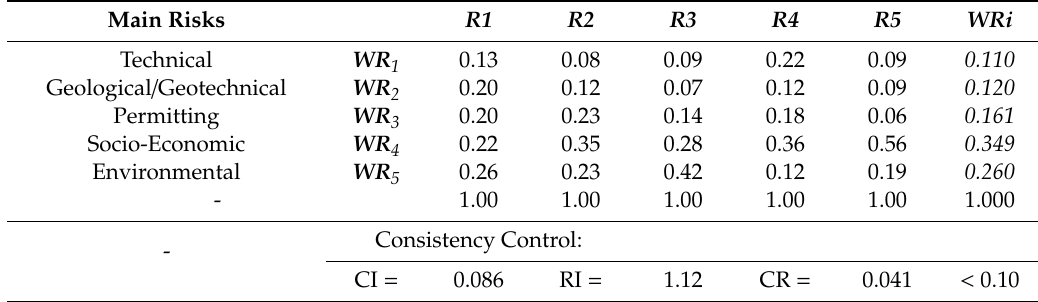
Table 10. Normalized Matrix and Priority Vector, WR i (Risk